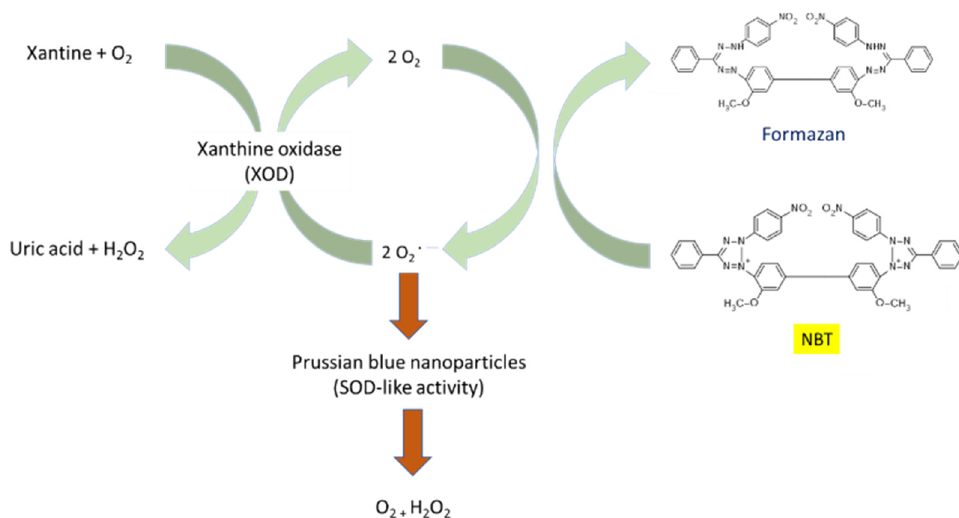
Figure 6. The conversion of xanthine and O 2 to uric acid and H 2 O 2 by XOD generates superoxide radicals. The superoxide anions reduce the nitroblue tetrazolium [NBT] to a colored formazan product that absorbs radiation at 560 nm. PBNPs scavenge superoxide anions, thereby reducing the rate of formazan formation.